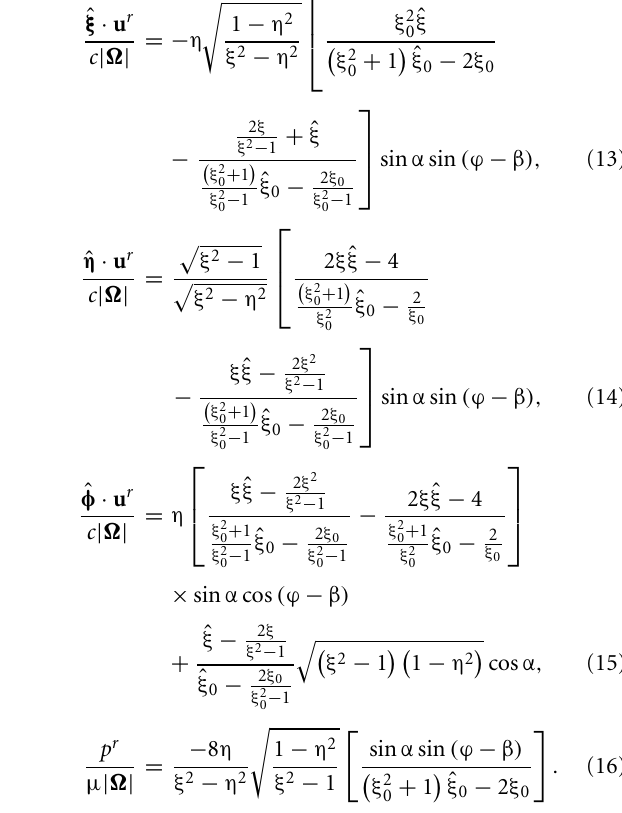
where the angles α and β specify the direction of (cid:2) in the carte- sian coordinates ( x , y , z ) . A three-dimensional velocity u r and the corresponding pressure p r describing the Stokes flow driven by a rotating rod-shaped bacterium with the angular velocity (cid:2) at arbitrary rotating angles α and β